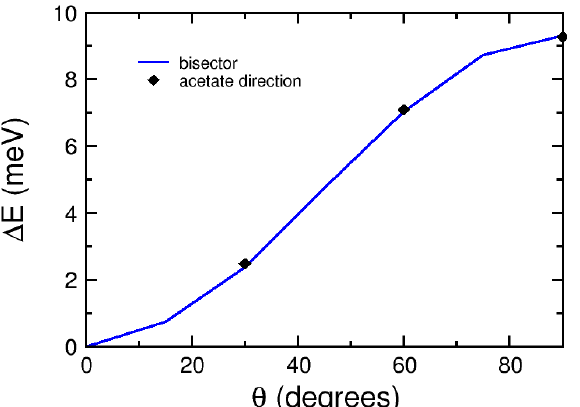
Figure 3. The total energy of the system as a function of the polar angle θ between the total magnetic moment and the molecular Mo-Mo axis (the axis of easy magnetization—EMA). The energy is referred to the ground state with the magnetization aligned along the EAM. The two sets of data refer to two values of the azimuthal angle φ : 0 ◦ (direction of one acetate arm–black diamonds), and 45 ◦ (bisecting direction between neighboring arms–blue solid